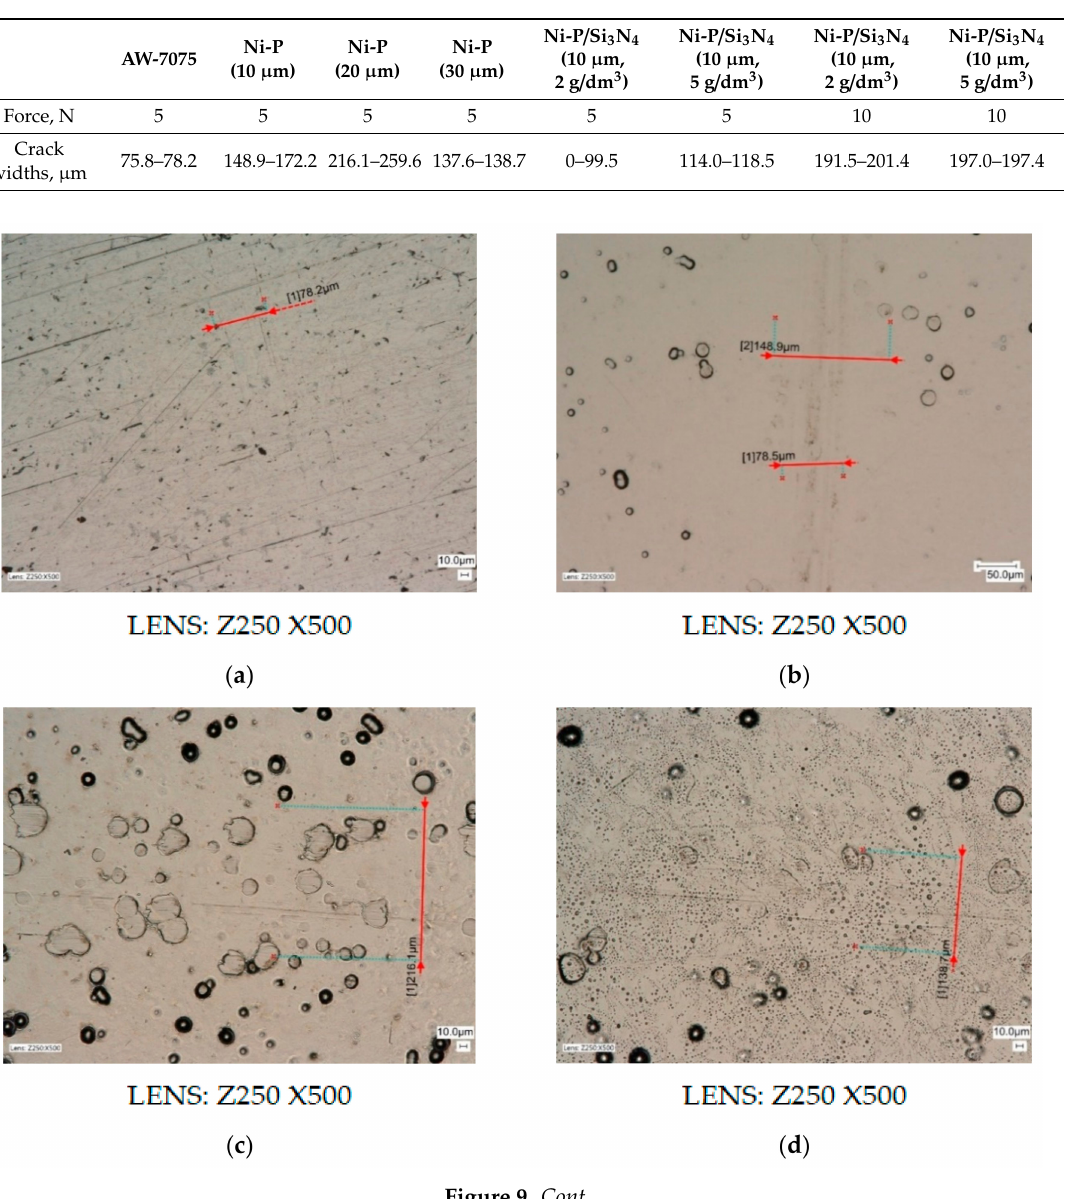
Table 9. Crack widths after tribological tests (the second step).